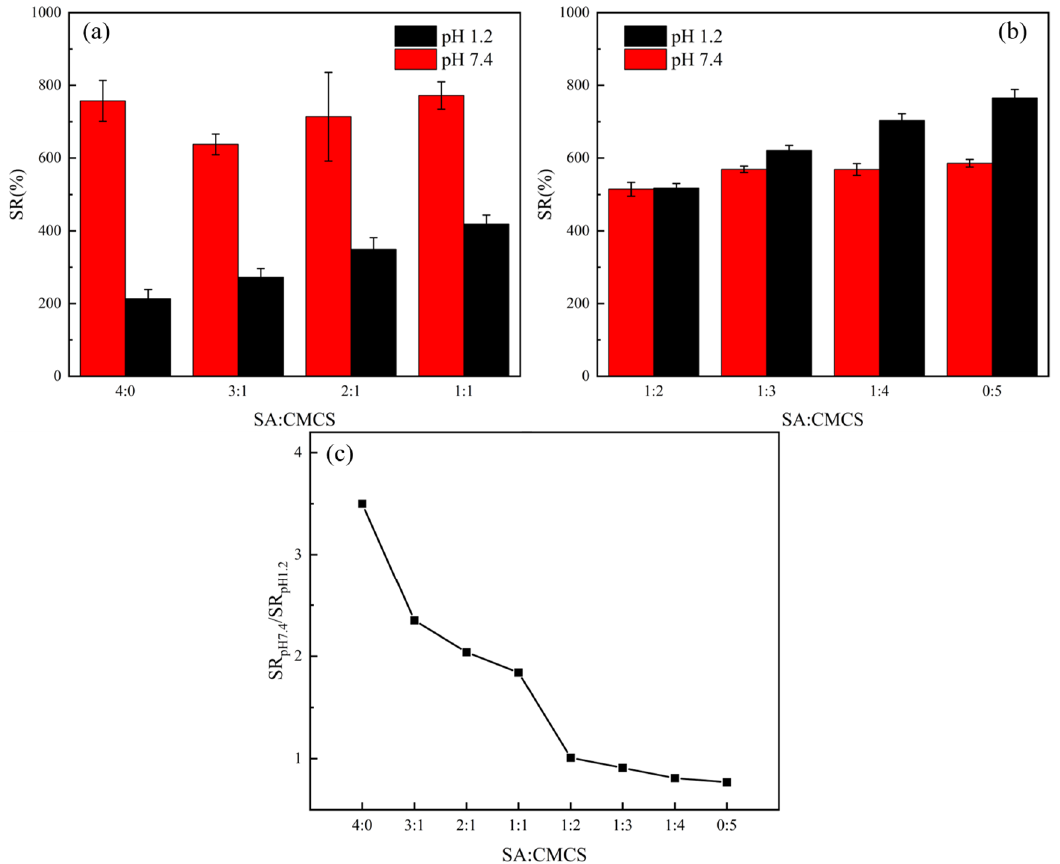
Figure 6. ( a , b ) Swelling rate between SA and CMCS on pH-responsive properties of hydrogels. ( c ) Ratio of the swelling rate between pH 7.4 and 1.2.